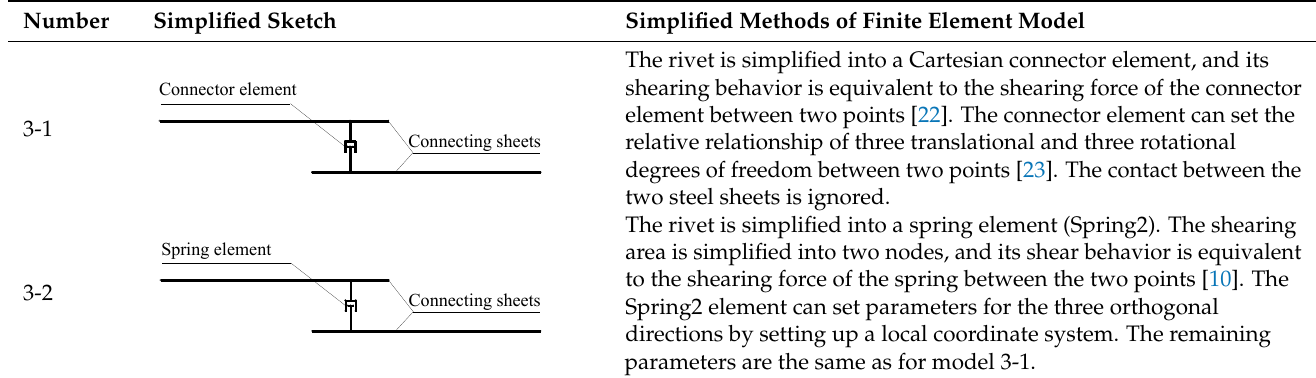
Table 7. The third simplified methods of the finite element model for the SPR joint.